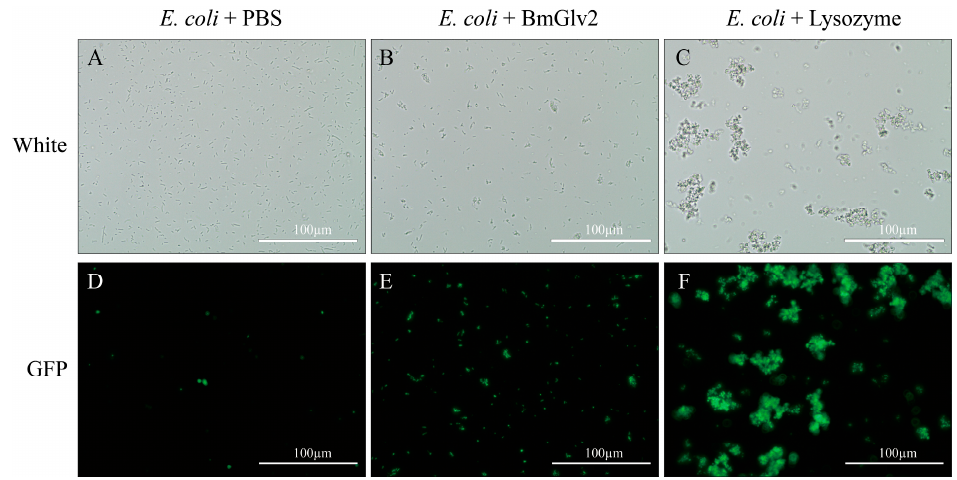
Figure 5. The lethal activity of BmGlv2. ( A – C ) The images under bright light. ( D – F ) The images under fluorescent light. The scale bar was marked in the picture. PBS was used as a negative control and the lysozyme was used as a positive control.